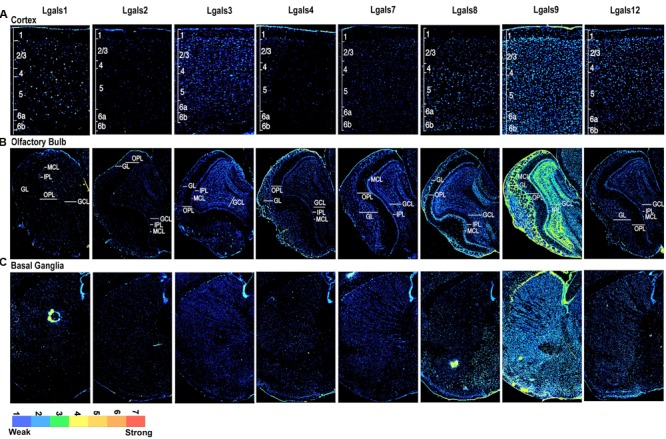
Galectins expression in mouse Cerebral Cortex, Olfactory Bulb, and Basal Ganglia (A) Expression profile of galectins in cortex with individual cortical layers marked from L1 to L6b. (B) Expression profile of galectins in olfactory bulb (OB), with different cell layers labeled as GL, glomerular layer; IPL, inner plexiform layer; OPL, outer plexiform layer; MCL, mitral cell layer and GCL, granule cell layer. (C) Expression profile of galectins in basal ganglia (BG).